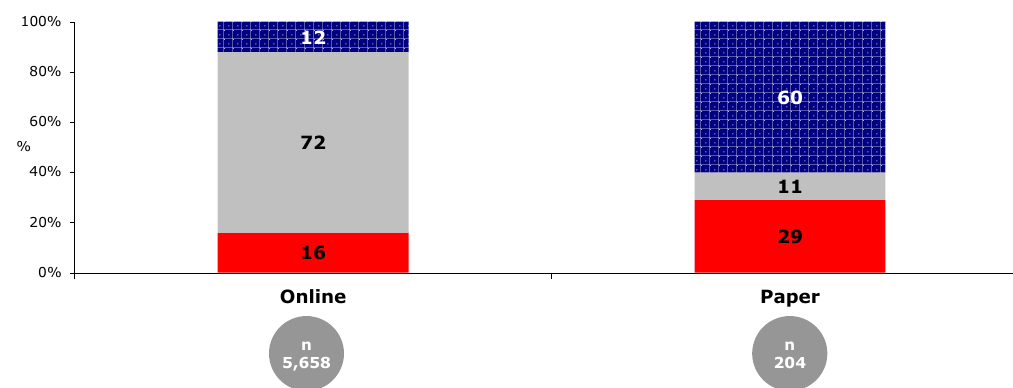
Figure 5. Reasons for “I can, but struggle” and “I can’t” (student